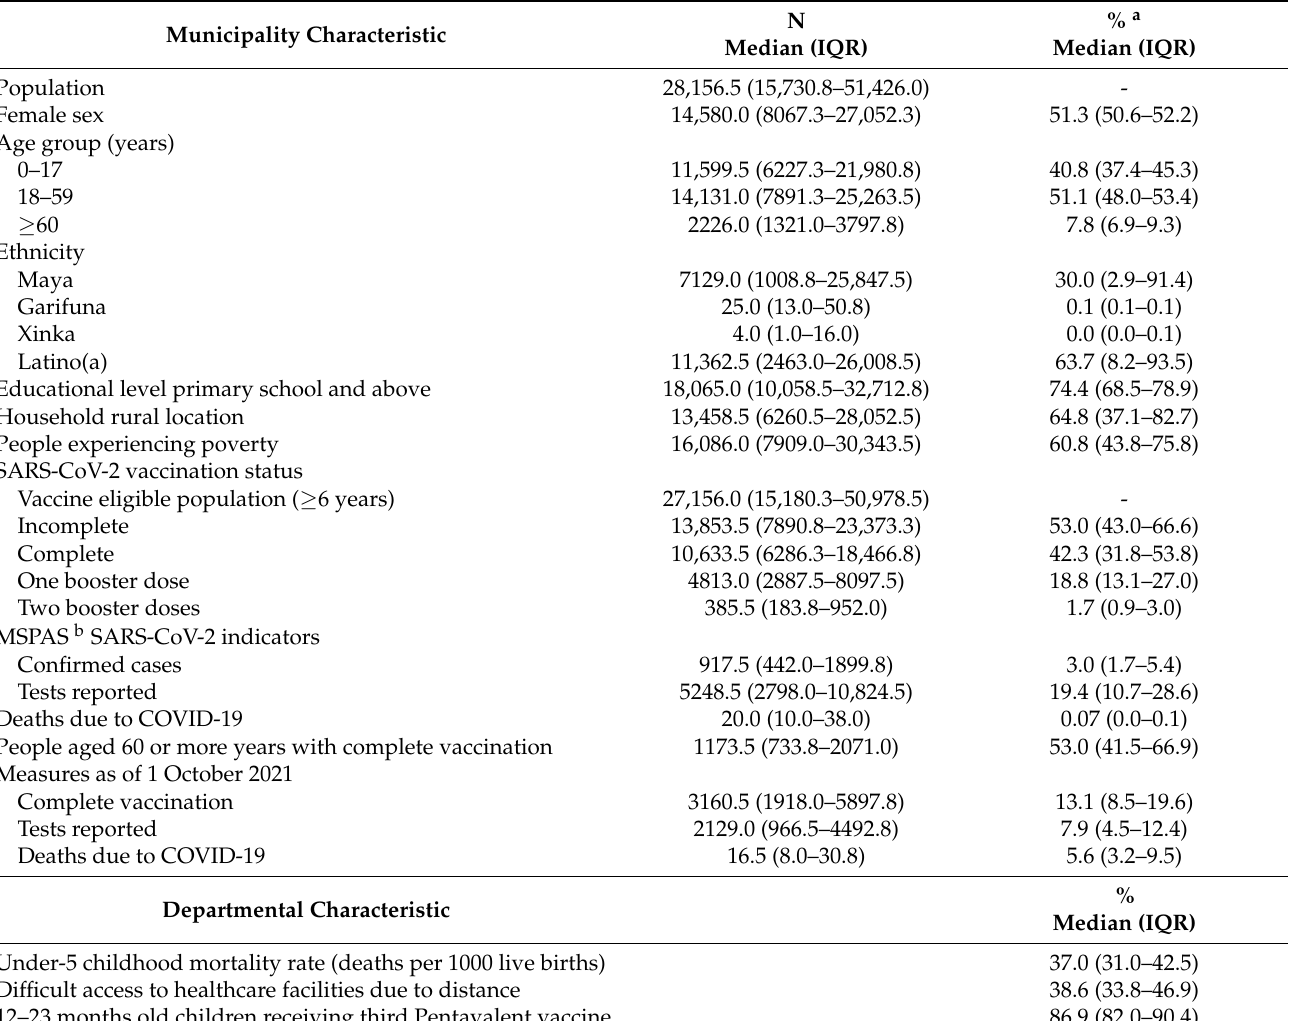
Table 2. Demographic characteristics among the 340 municipalities and 22 departments in Guatemala. Data source: Guatemala Population and Housing Census 2018, 2014–2015 Demographic and Health Survey, and Guatemala Ministry of Health and Social Assistance. The poverty variable is a